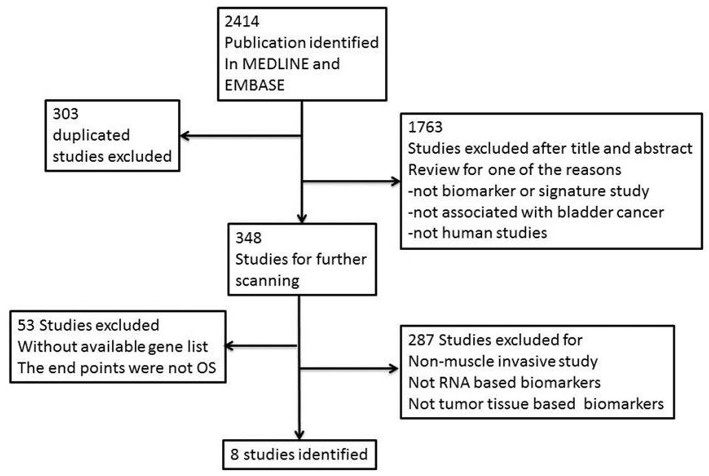
Flow chart of the selection of gene signature studies predicting the OS of MIBC.